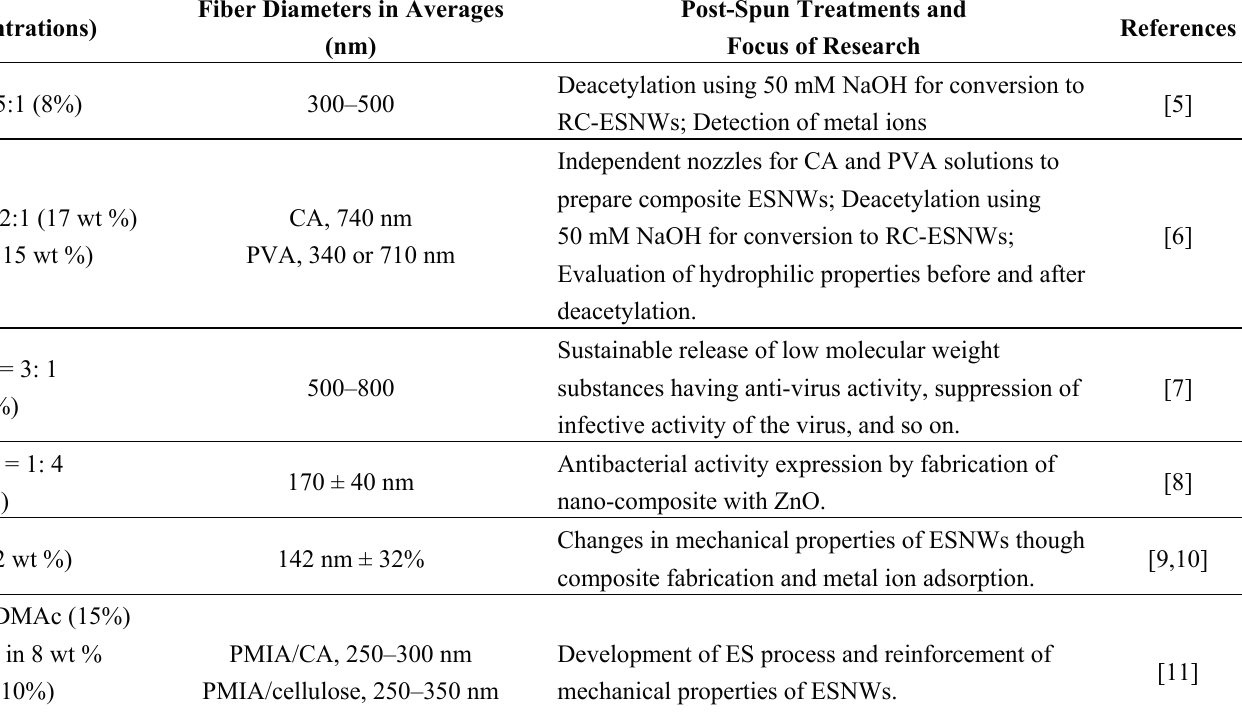
Table 1. List of publications on cellulose- and cellulose-derivative-ESNWs (publication year, ca. 2010 to 2012). Matrix